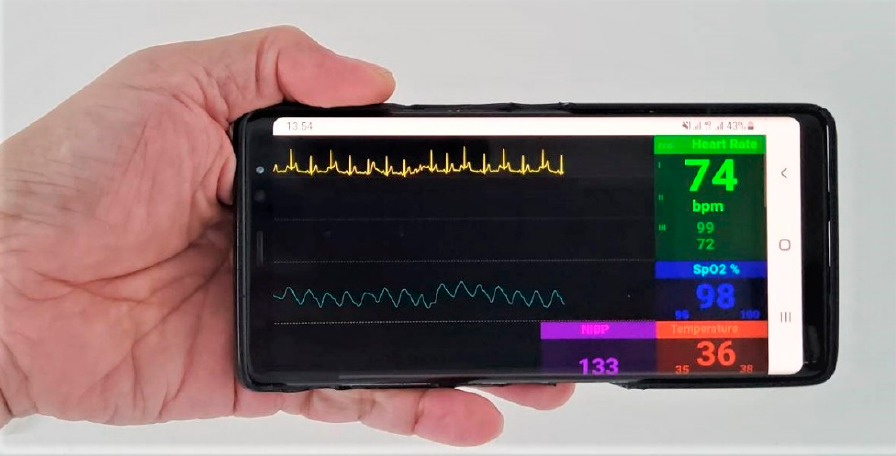
Figure 12. Vital-sign monitoring page on 4G Mobile Network with download speed of 20 Mbps.